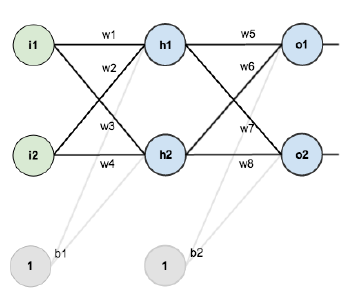
Figure 12. Weight between nodes of a neuronal network.